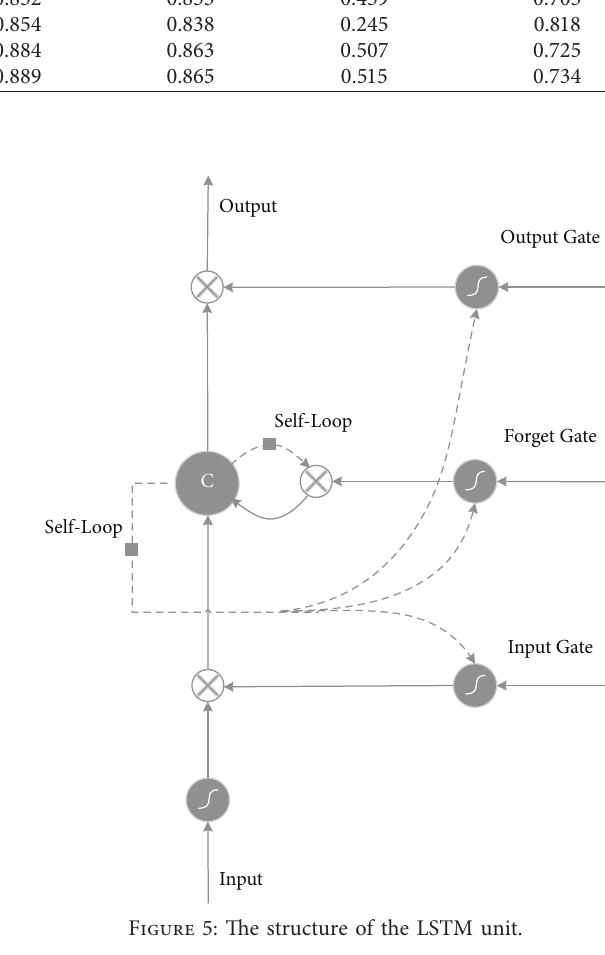
Figure 5: The structure of the LSTM unit.